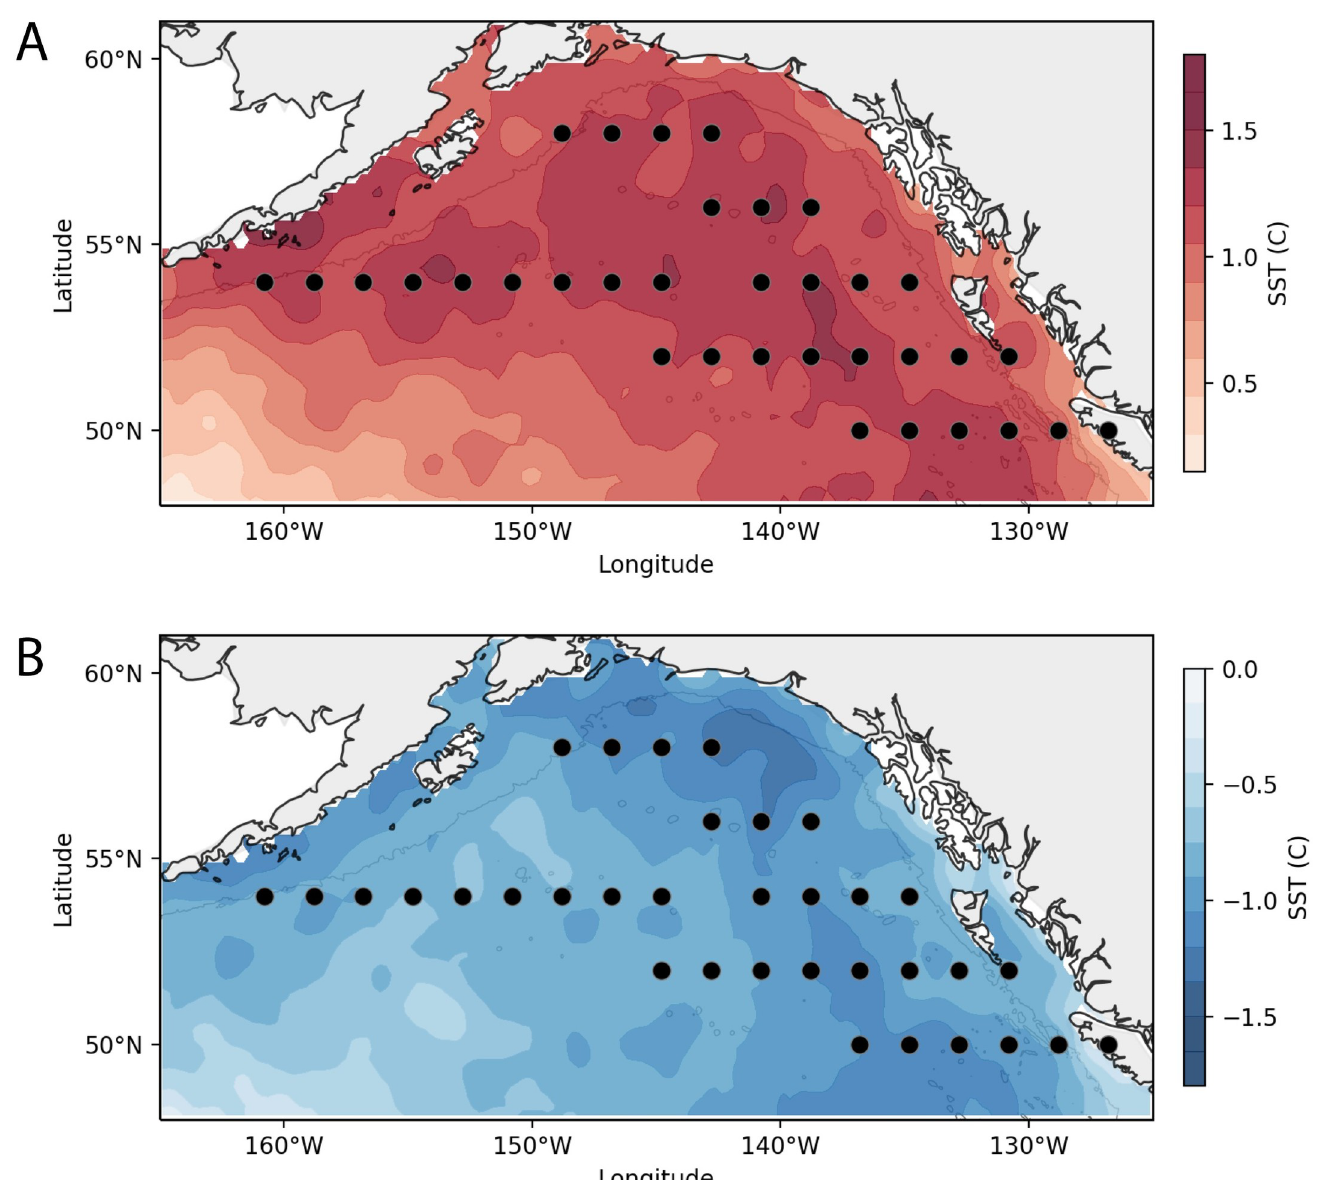
Fig 8. Temperature anomalies during warm and cold years. Study maps depicting SST patterns between (A) warm and (B) cold years, with center-points of sampled grids (black